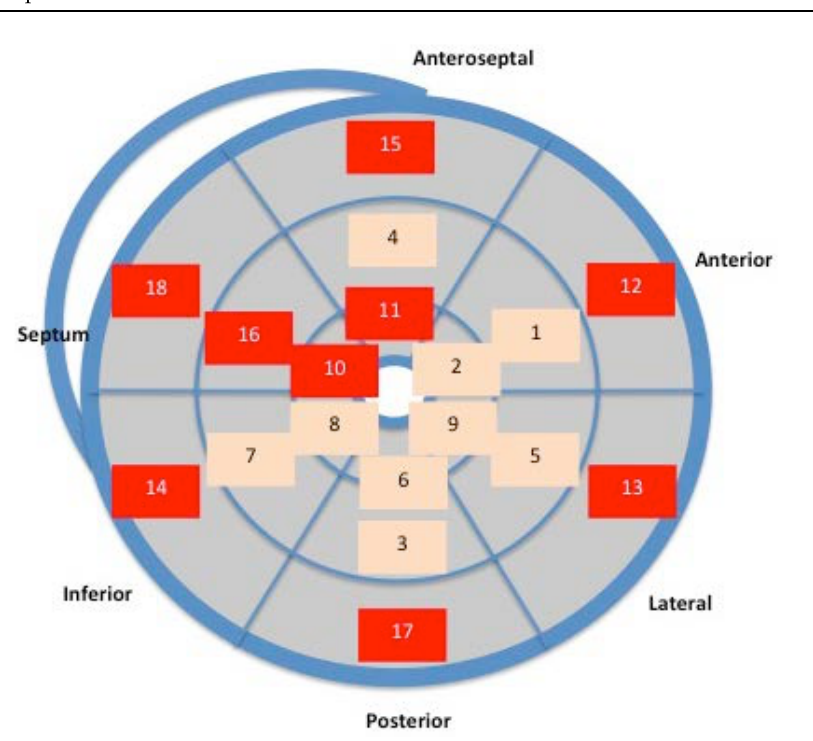
Figure 4. Segmental sequence of the mean time to longitudinal latest deformation (LD) in the 18 segments of the LV. The segments where LD occurs earliest are in yellow, and those where the peak of deformation occurs latest are in red.